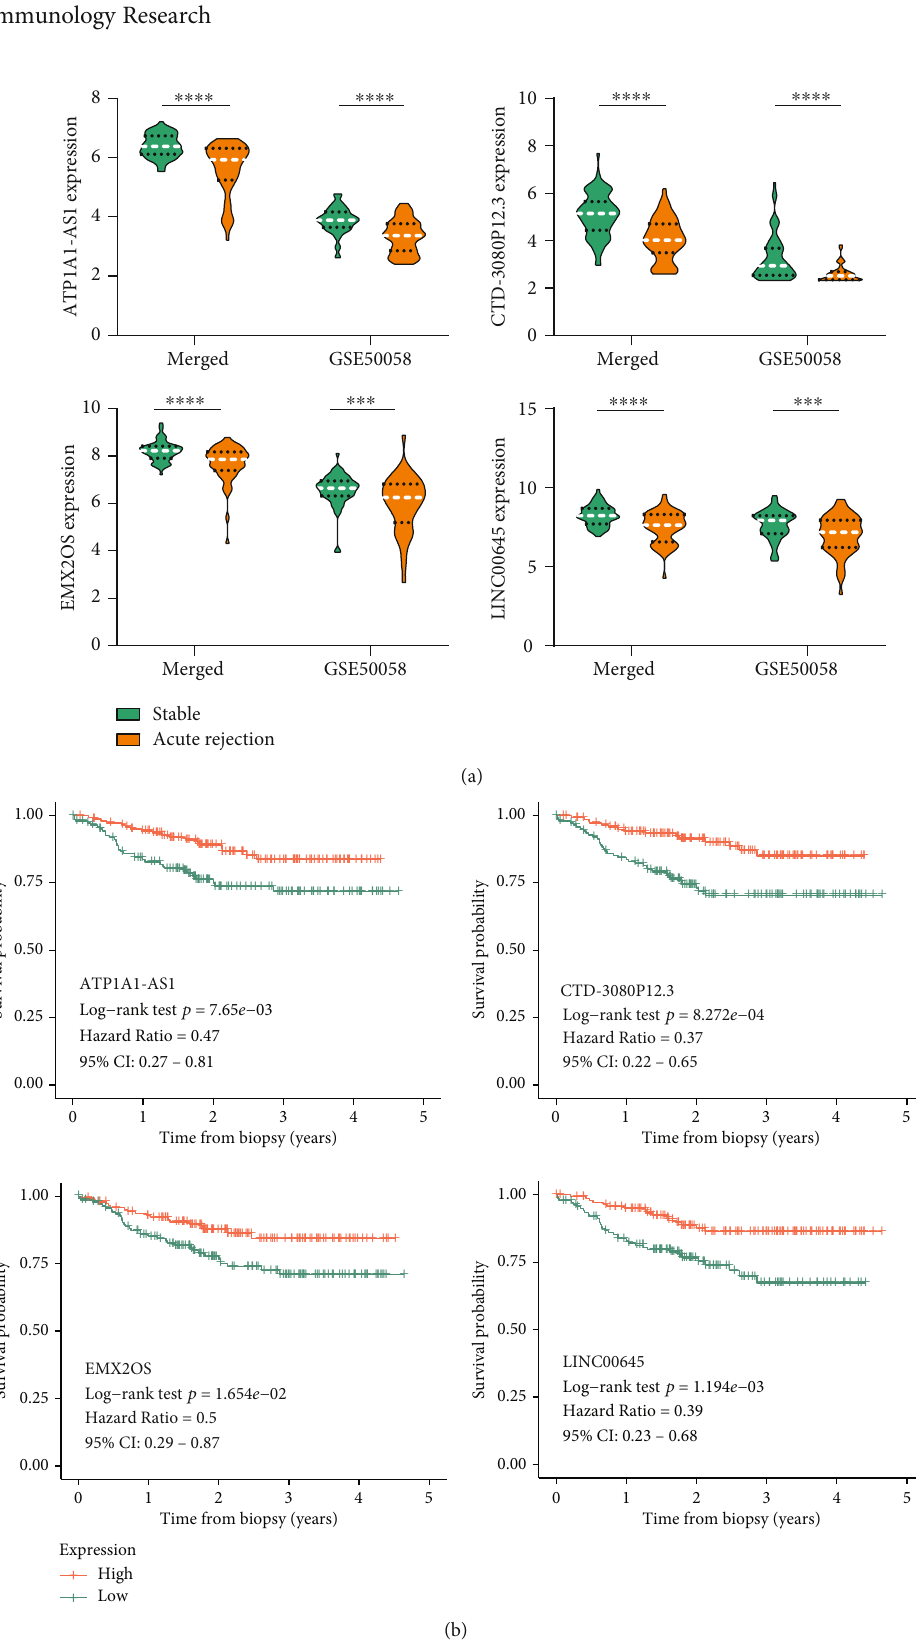
Figure 4: Expression pattern and Kaplan-Meier survival analysis of the optimal 4 lncRNAs. (a) The expression pattern of ATP1A1-AS1, CTD-3080P12.3, EMX2OS, and LINC00645 in the merged dataset and GSE50058 dataset. (b) Graft survival analysis of ATP1A1-AS1, CTD-3080P12.3, EMX2OS, and LINC00645 in the patients of GSE21374 datasets. ∗ p < 0 : 05 , ∗∗ p < 0 : 01 , ∗∗∗ p < 0 : 001 , and ∗∗∗∗ p < 0 : 0001